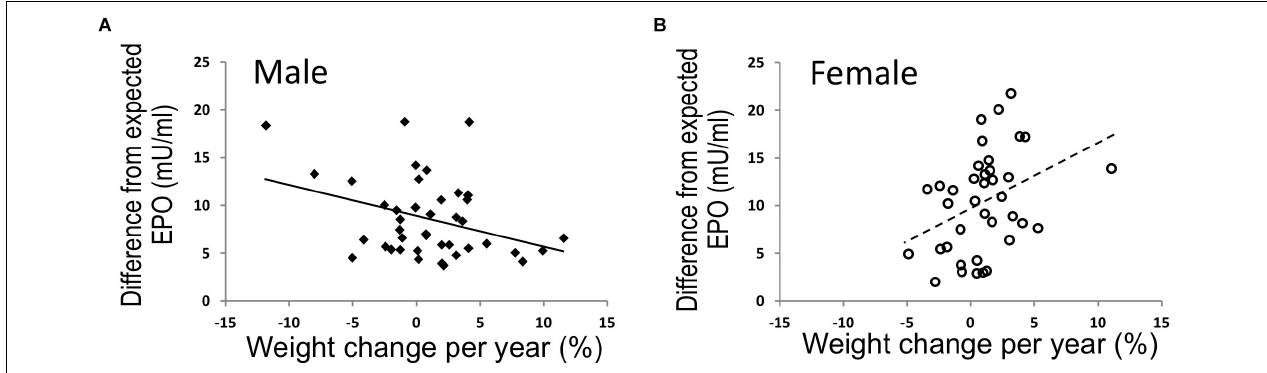
FIGURE 5 | EPO and % weight change per year were associated in opposing directions in males and females. (A,B) In full-heritage Southwestern Native Americans, the association of plasma EPO concentrations (adjusted for creatinine, hemoglobin, and storage time) and % weight change per year was negative in men (A) (closed squares, N = 41; r = –0.35, p = 0.02). Plasma EPO concentration was positively associated with % weight change per year in females (B) (open circles, N = 38; r = 0.37, p = 0.02) (modified from Reinhardt et al., 2016, with